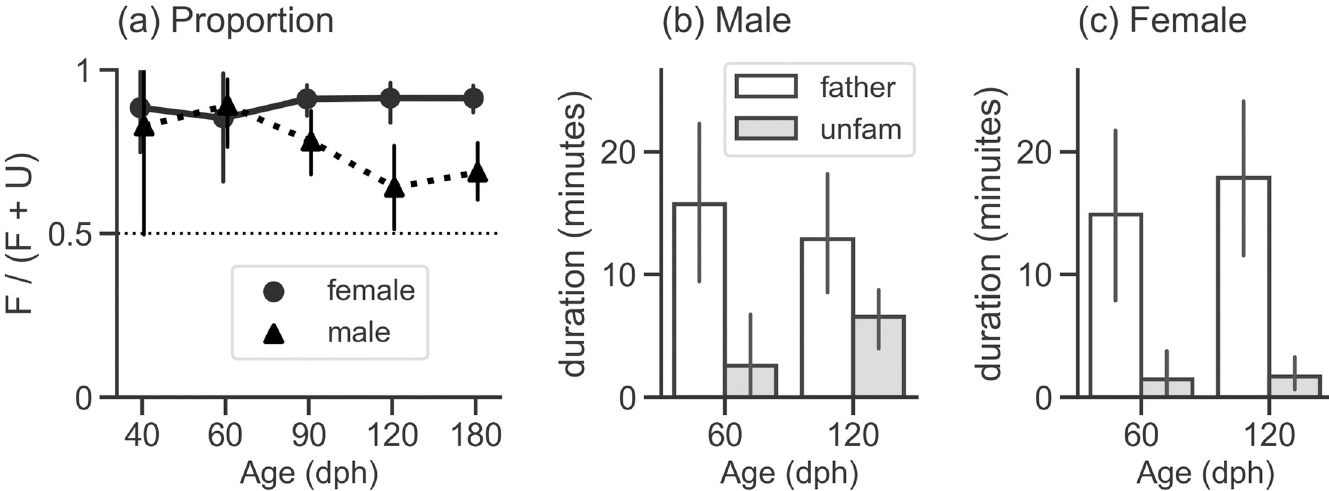
Fig 2. Results of the preference test (phonotaxis). (a) Population mean of the response proportion plotted against age of testing (the number of individuals of each sex at each age is specified in Table 1). A solid line with filled circles indicates female data, and a dashed line with filled triangles indicates male data. The proportion was calculated as the duration of time a bird spent in the approach zone of the father’s song (F) divided by the total duration of time spent in two approach zones (F + U). (b, c) Population mean of time spent (seconds) in either approach zone in the tests conducted at 60 and 120 dph in males (b) and females (c). We used logarithmic transformation of this time duration data for all individuals (10 males and 10 females) for model fitting. Open bars and grey bars indicate response to the father’s song and unfamiliar song, respectively. In all three panels, error bars are 95% confidence intervals. Mean and confidence interval values were summarized in Table 1.